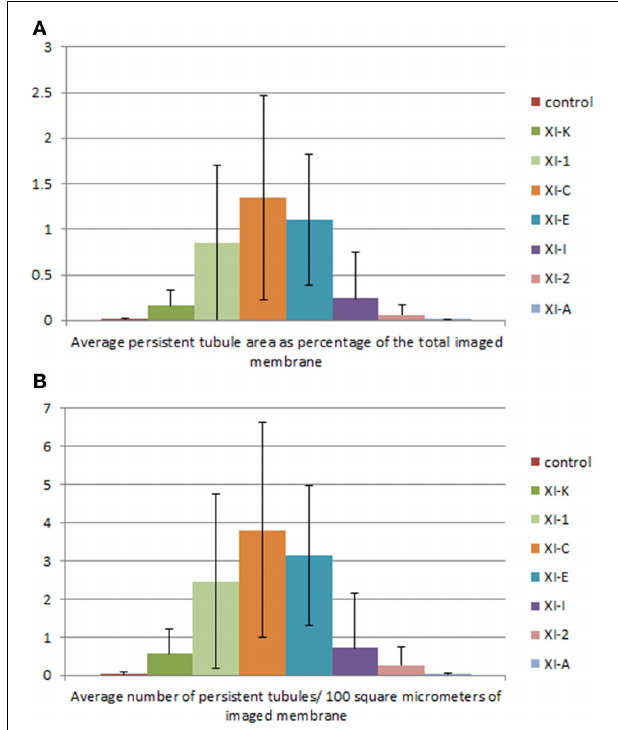
FIGURE 4 | Quantification of the effects of the myosin tail domains on persistent ER tubules. (A) Counts of the cumulative percentage area of highly persistent tubules (see Figures 2 , 3 for examples). (B) Counts of the number of persistent tubules per hundred square micrometers of ER membrane analyzed for all of the myosin subclasses. Error bars represent standard deviation. The level of significance of the difference between the samples is described in Table 1